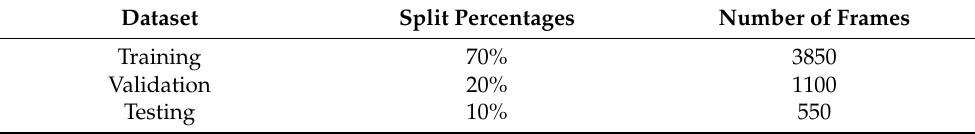
Table 1. Dataset split for detection model.